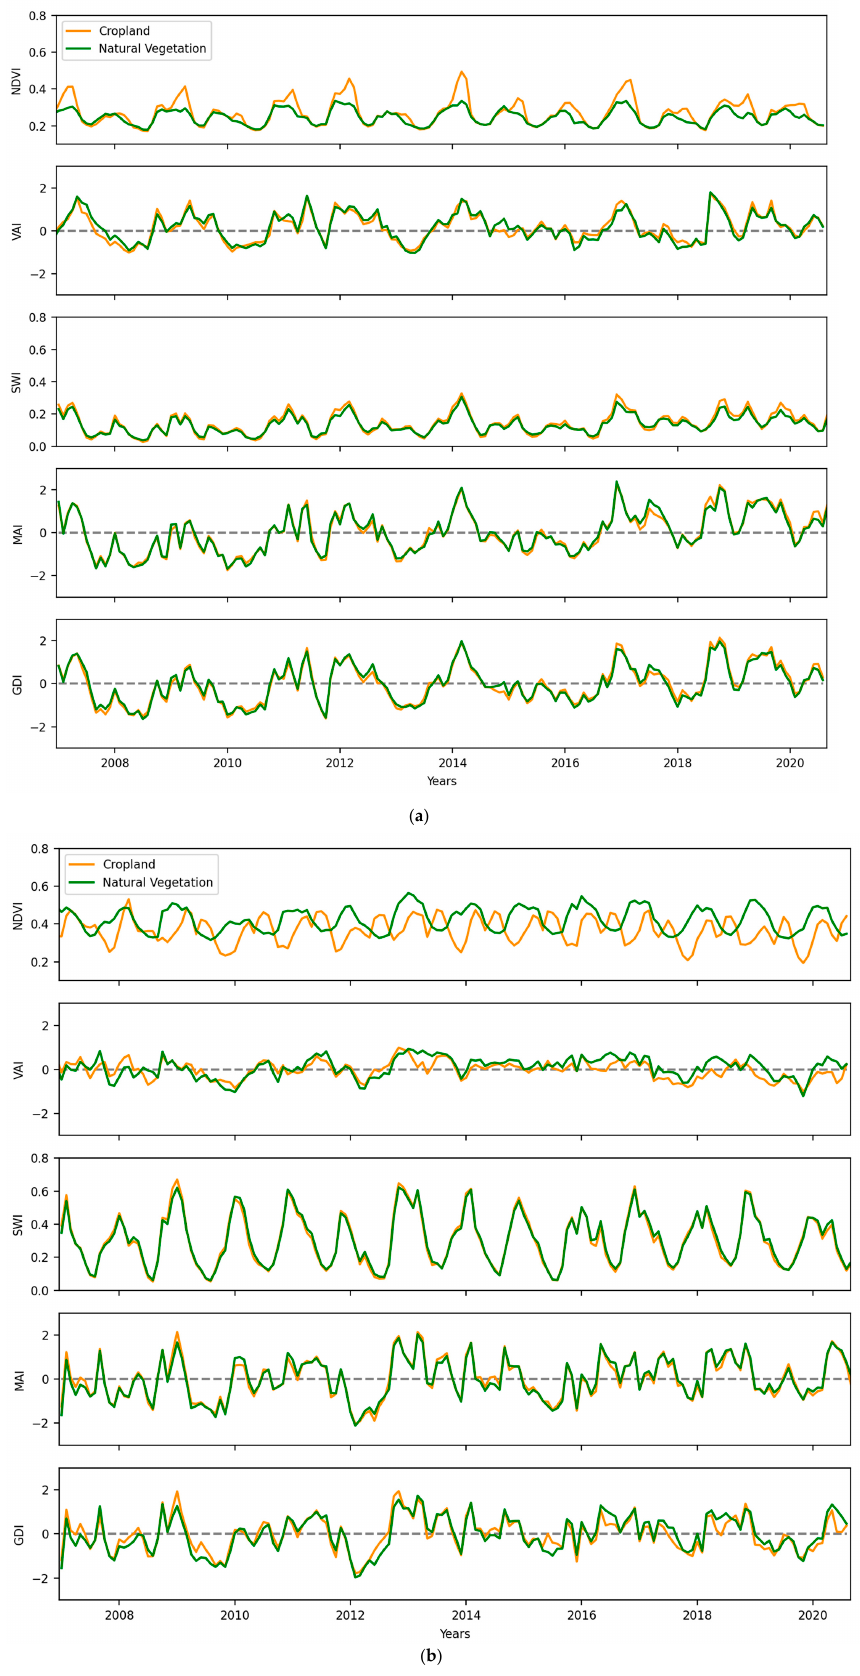
Figure 10. NDVI, SWI, VAI, MAI, and GDI time series at two test sites ( a ) Kairouan and ( b ) Andalusia.